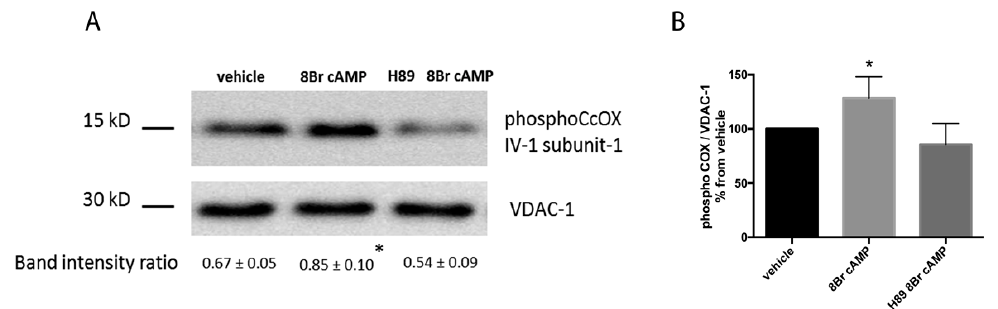
Figure 3. Representative Western blot images showing mitochondrial protein levels of Ser-58 phosphorylated cytochrome c oxidase (CcOX) subunit IV-1 of control mitochondrial fractions after incubation with 8Br cAMP with or without H89 pre-exposure. Results of densitometric quantification of blots normalized for voltage-dependent anion channel (VDAC)-1, (band intensity ratio) are displayed as mean ± SD ( A ); and expressed as percent changes ( B ). Results were analyzed with one-way ANOVA and Bonferroni’s multiple comparison post hoc adjustment ( n = 6; * indicates adjusted p < 0.01 versus vehicle).